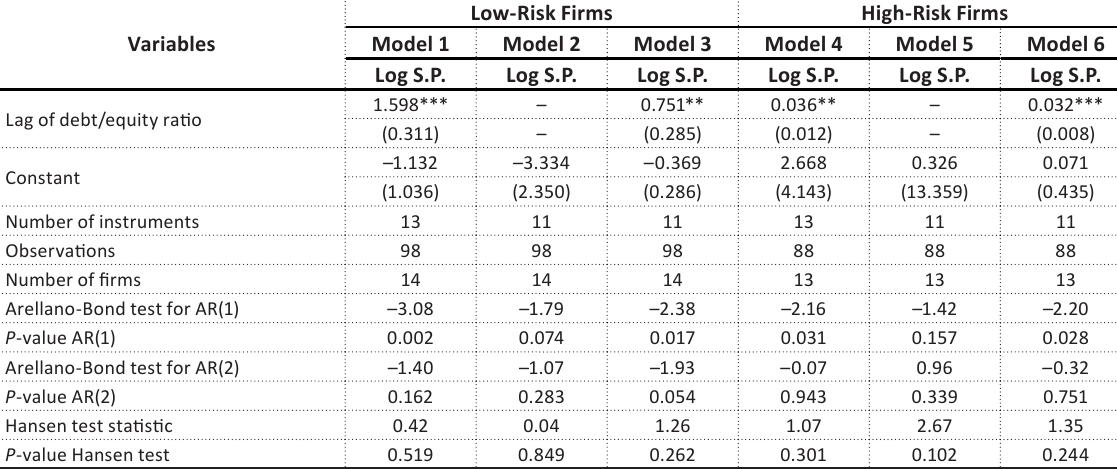
Table 4 (cont.). Regression results for sub-samples